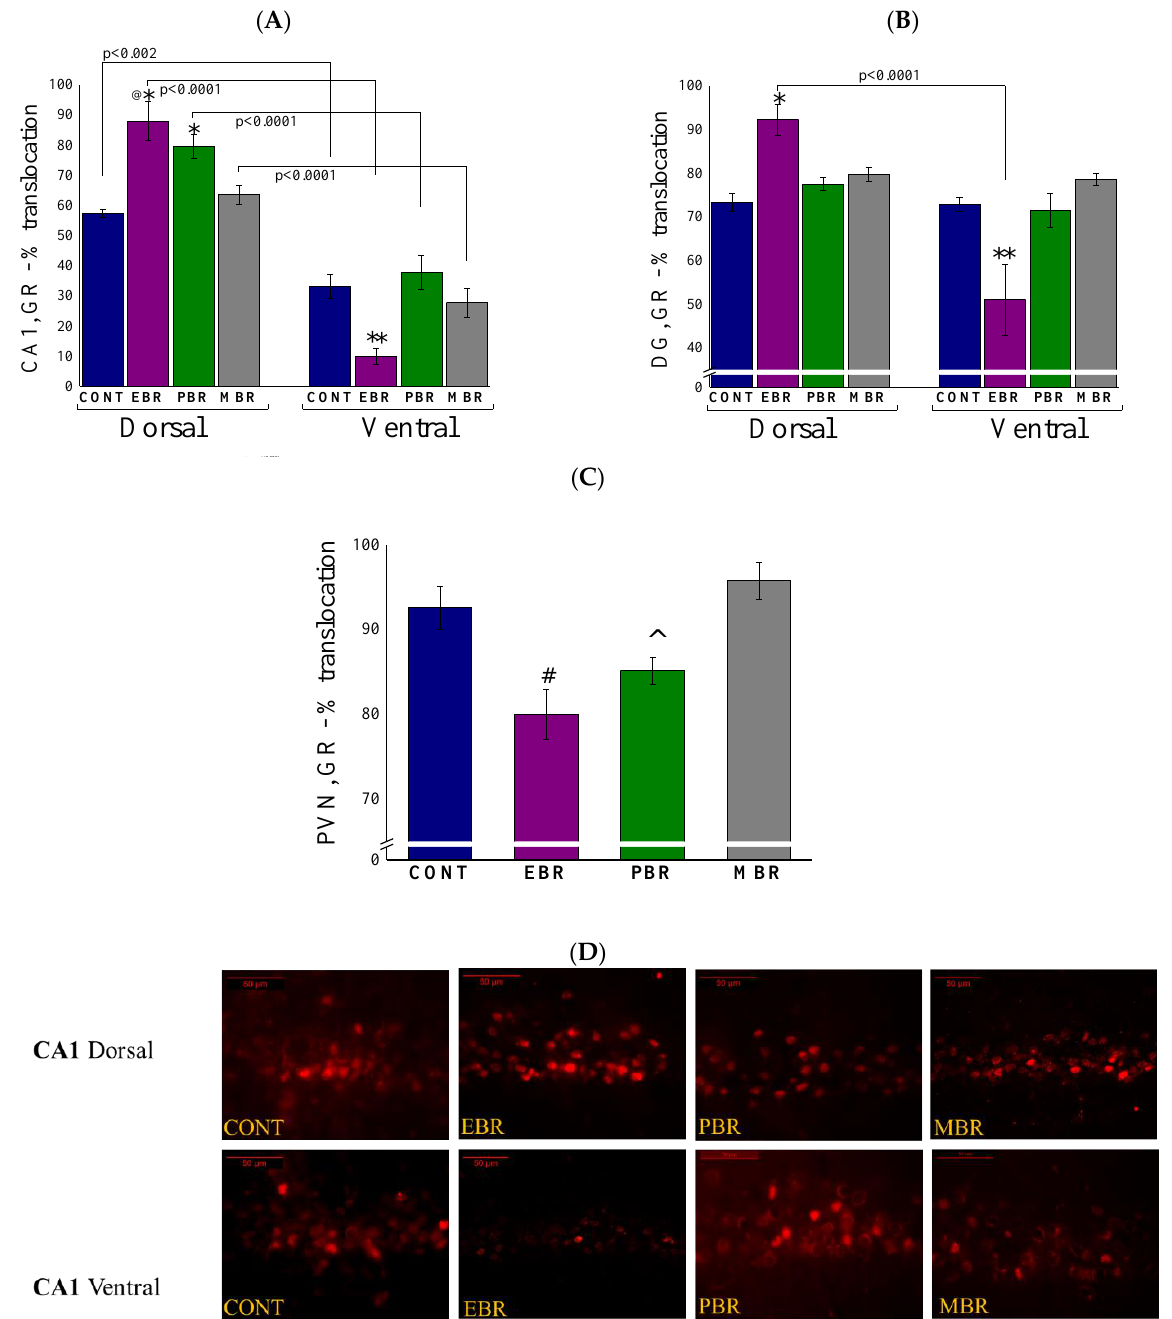
Figure 5. Brain GR-ir cells 8 days post-PSS exposure. Immunohistochemistry of GR in specific brain areas 8 days post-PSS exposure. Significant differences between dorsal and ventral parts are depicted in the graphs, whereas notations are given for significant differences between groups in the same area and are explained in this legend for each graph separately. ( A ) GR-IR in the CA1 region of the ventral and dorsal hippocampus [* significant as compared to dorsal control ( p < 0.002); @ significant as compared to dorsal MBR ( p < 0.04); ** significant as compared to ventral control and PBR ( p < 0.05)]. ( B ) GR-IR in the ventral and dorsal dentate gyrus [* significant as compared to dorsal control ( p < 0.04); ** significant as compared to ventral control, PBR and MBR ( p < 0.009)]. ( C ) GR-IR in the PVN [# significant as compared to control and MBR ( p < 0.02); ˆ significant as compared to MBR ( p < 0.015)]. ( D ) Representative images of GR-immunoreactivity in the dorsal and ventral CA1 subregion of CONT, EBR, PBR, and MBR groups. Images were acquired at 40 × magnification. Scale bar: 50 µ m. The cells in red are